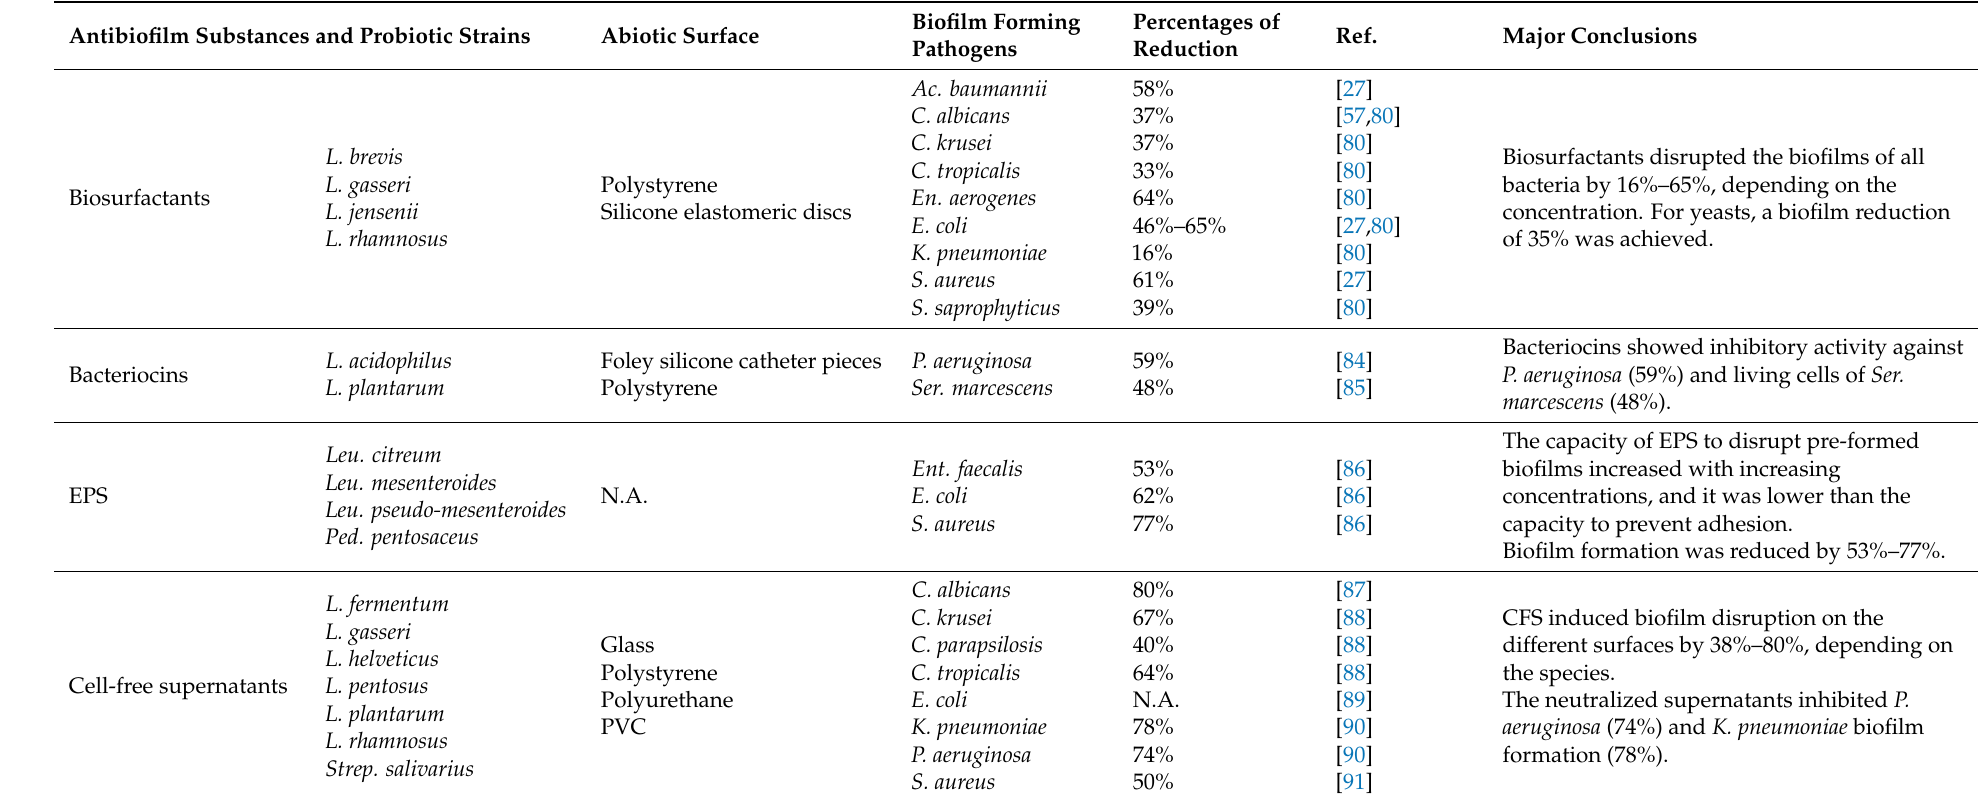
Table 1. Displacement studies in medical